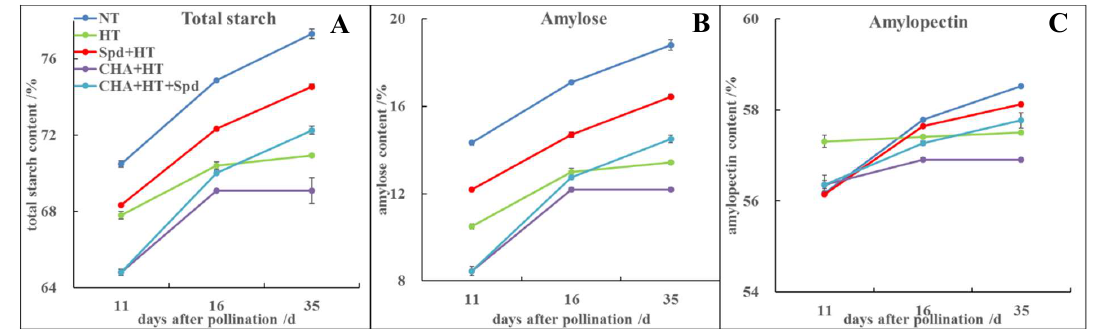
Figure 3. Effects of exogenous Spd and CHA on the contents of ( A ) total starch, ( B ) amylose, and ( C ) amylopectin in rice seeds at different developmental stages under high-temperature stress. The treatment methods were the same as those in the Figure 1 notes.